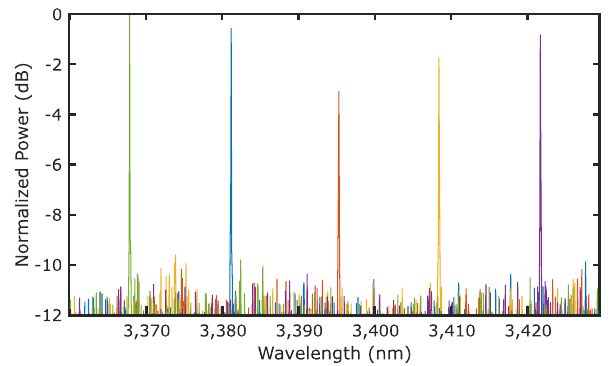
Fig. 5 Tuning of the lasing wavelength in the locked-state laser. Optical spectra showing the wide tunability of the locked-state laser of over 54 nm in wavelength near 3.4 μ m. Green, blue, orange, yellow, and purple lines represent lasing wavelength tuning for 0 mW, 24 mW, 37 mW, 66 mW, and 99 mW of electrical power applied to the microheater on top of the ring resonator, respectively. In addition, less than 100 mW of electrical power was applied to the microheater on top of the adjacent bus waveguide for phase matching.